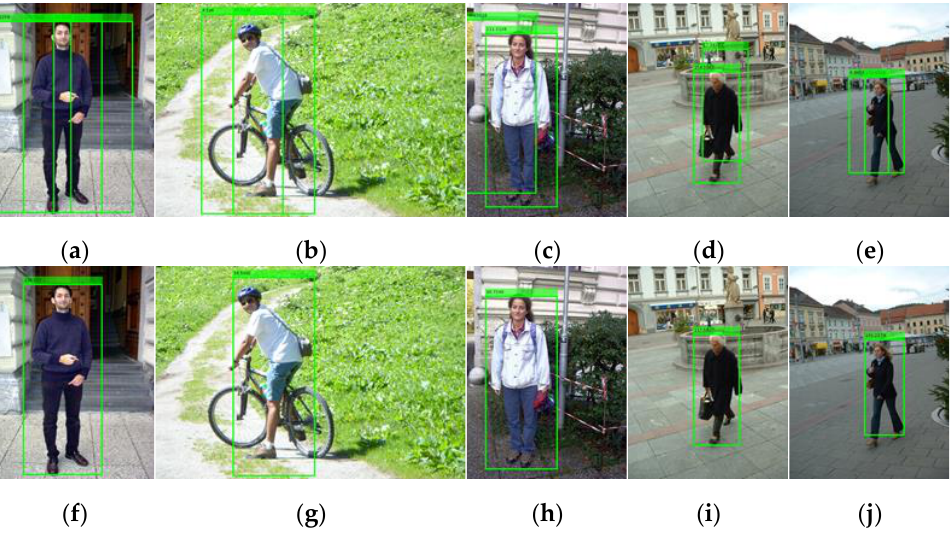
Figure 17. The results of the MTCNN + ACF detector with 𝑓 𝑠𝑠 = 8 ( a – e ) and the ACF detector ( f – j ). Both detectors utilize the default threshold.